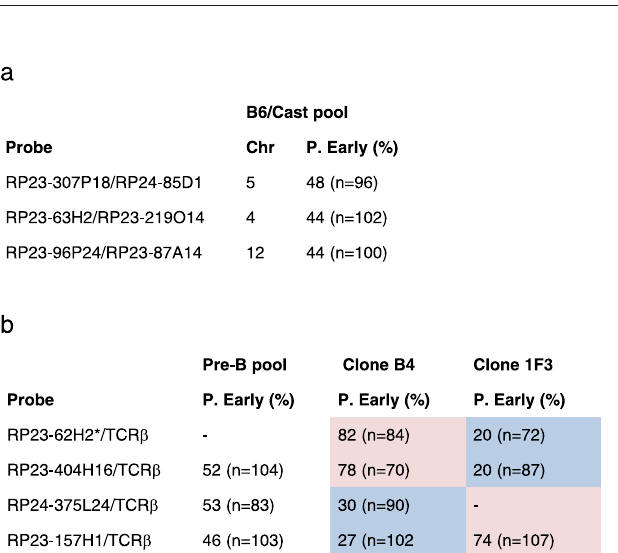
Fig. 4 Orientation of asynchronous replication regions. a Whole-genome chromosome map of all AS-replication regions ’ orientation (Cast early, blue; B6 early, red). b Representative double-label FISH images showing nuclei with single/double hybridization patterns for two probes on the same chromosome. Probes R-83L7 and RP23-63H2 show a parallel pattern of hybridization with both double signals on the same allele (top), while probes RP24-83L7 and RP23-439A9 show an antiparallel pattern with each allele carrying one single and one double hybridization signal (bottom). c Comparison of asynchronous region pairs (A/B or A/C) on three different chromosomes (Chr16, Chr4, Chr12) using double-label FISH as shown in b . Table shows the percent of single/ double nuclei with antiparallel allelic replication patterns. The position of regions A, B, and C for each chromosome is shown on the adjacent replication- time (RT) maps (right) derived from clone E-5. All measurements were carried out on two independent pre-B cell clones and in ES cells. The maximum p value for all cases was <2 × 10 − 4 as determined by the two-tailed binomial test. BAC probes used in this experiment were as follows: Chr16 (A = RP23- 38D22, B = RP23-326K16, C = RP23-59I11); Chr4 (A = RP24-83L7, B = RP23-439A9, C = RP23-63H2); Chr12 (A = RP23-13F5, B = RP24-386G17, C =